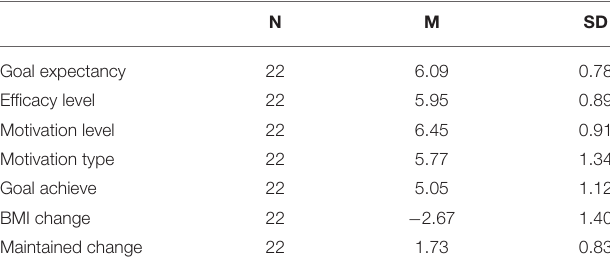
TABLE 2 | Means (M) and Standard deviations (SD) for variables included in the